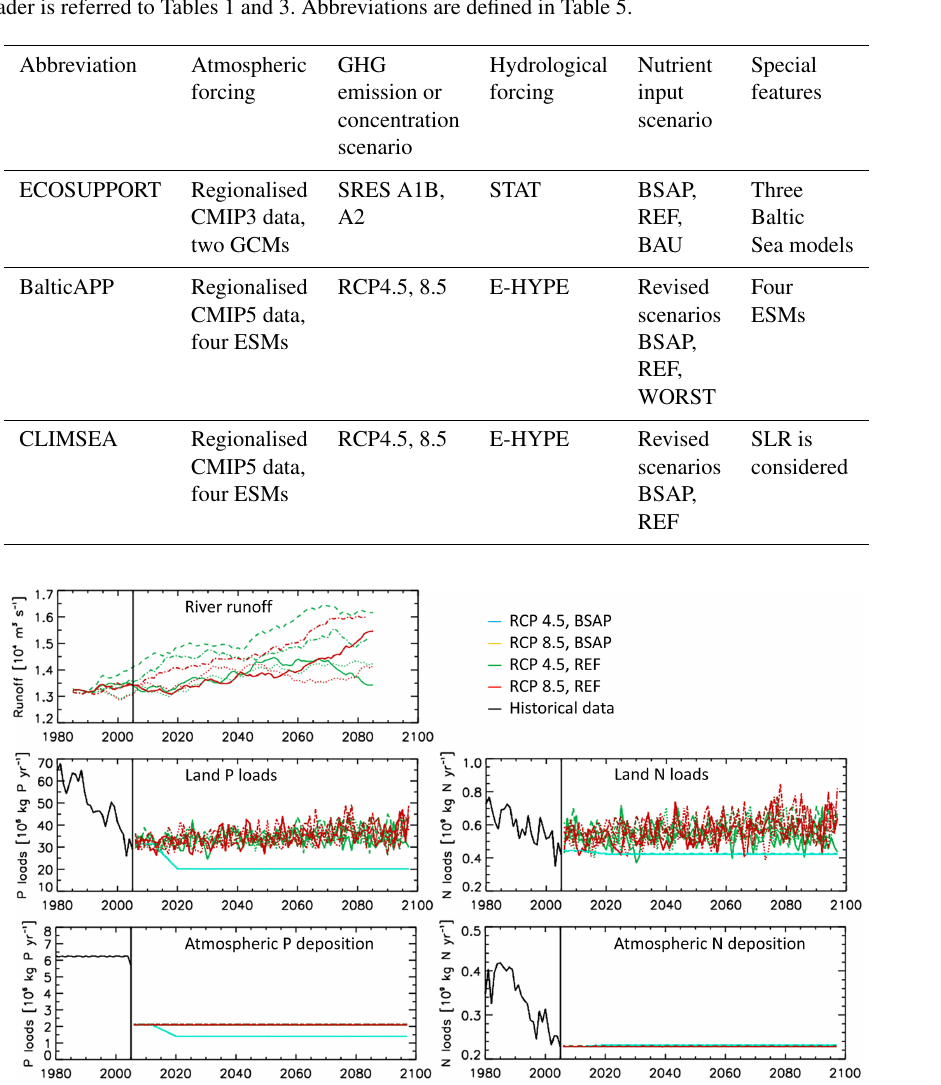
Figure 3. Projections of river discharge and nutrient inputs from land and atmosphere into the entire Baltic Sea according to the BalticAPP and CLIMSEA scenario simulations. Upper panel: low-pass-filtered runoff data (in m 3 s − 1 ) using a cut-off period of 30 years in four region- alised ESMs (illustrated by different line types) under RCP4.5 (green) and RCP8.5 (red) scenarios. Lower panels: bioavailable phosphorus (in 10 6 kgPyr − 1 , left panels) and nitrogen inputs (in 10 9 kgNyr − 1 , right panels) from land (upper panels) and the atmosphere (lower panels) under RCP4.5, BSAP (blue), RCP4.5, REF (green), RCP8.5, BSAP (orange) and RCP8.5, REF (red) scenarios. Nutrient inputs during the historical period are depicted in black. The nutrient input scenario WORST of the BalticAPP scenario simulations (Saraiva et al., 2019a; their Fig. 4) is not displayed, and neither are the ECOSUPPORT nutrient input scenarios (Gustafsson et al., 2011; their Fig. 3.1). (Source: Meier et al., 2021; their Fig. 3 distributed under the terms of the Creative Commons CC-BY 4.0 License, http://creativecommons.org/licenses/by/4.0/, last access: 6 January